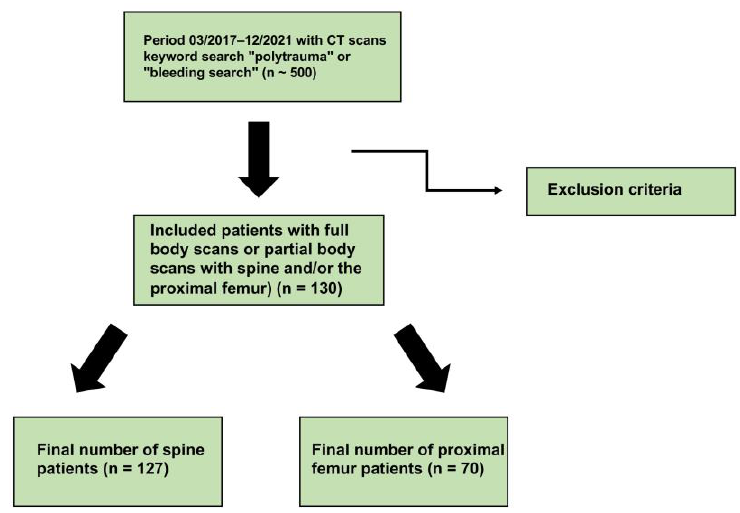
Figure 1. Flowchart about the study overview. After applying the exclusion criteria, 130 patients were integrated into the final examination.